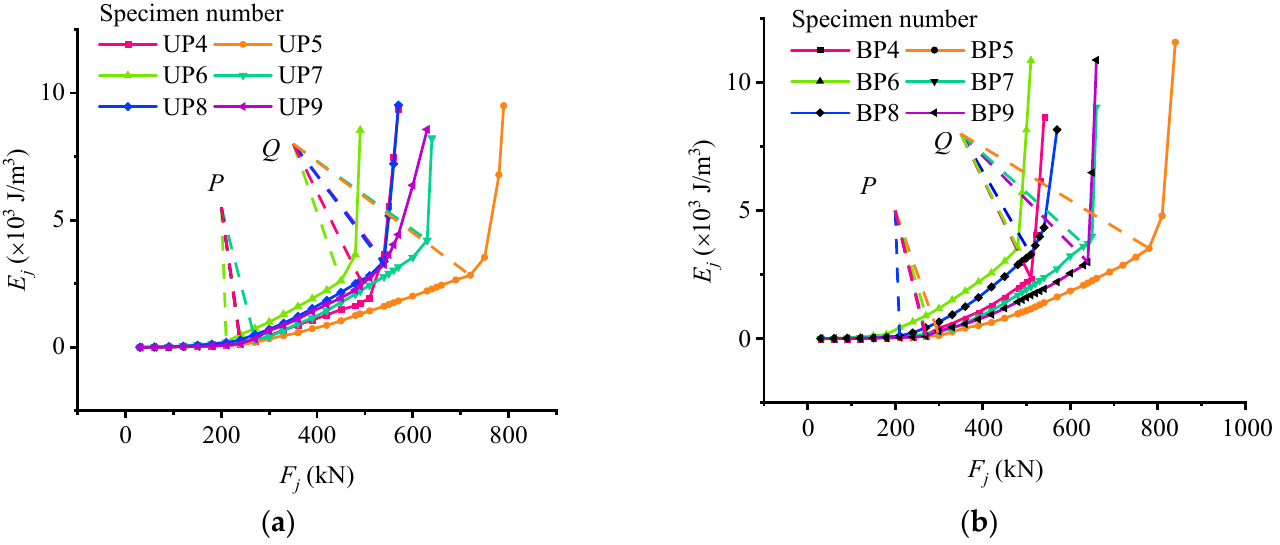
Figure 6. Strain energy density load curve: ( a ) strain energy load curve of unbonded partially prestress (UP) beam; ( b ) strain energy load curve of bonded partially prestress (BP) beam.